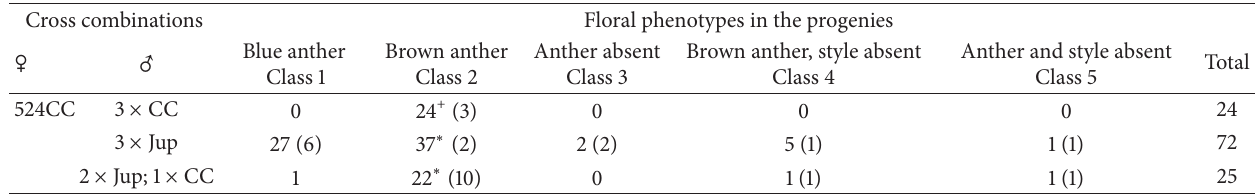
Table 3: Frequency of different phenotypes issued from crosses with Jupiter and CC pollen donors. Cross combinations Floral phenotypes in the